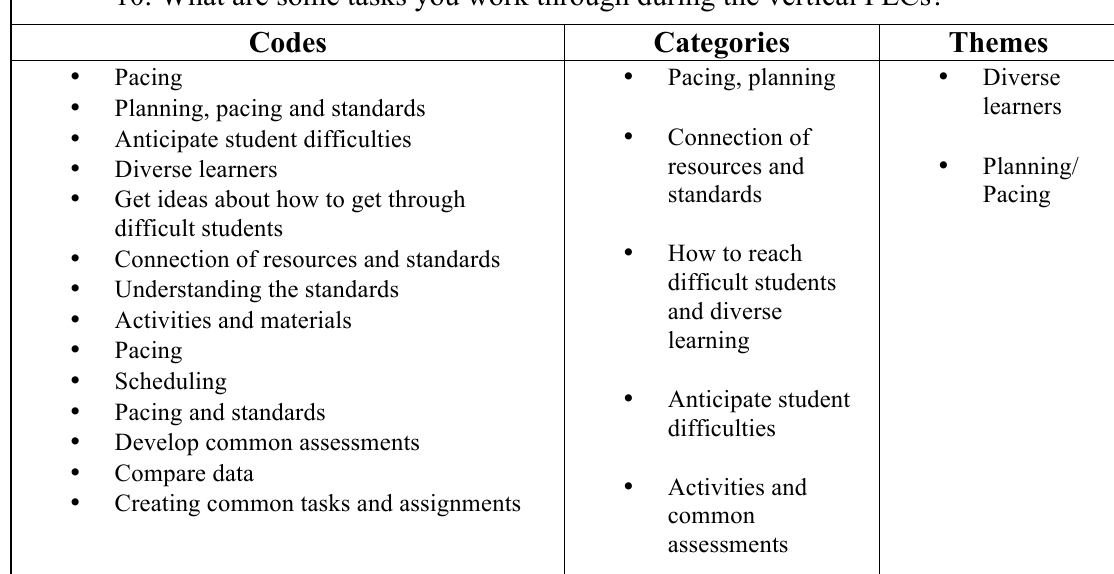
Teacher Question Ten and